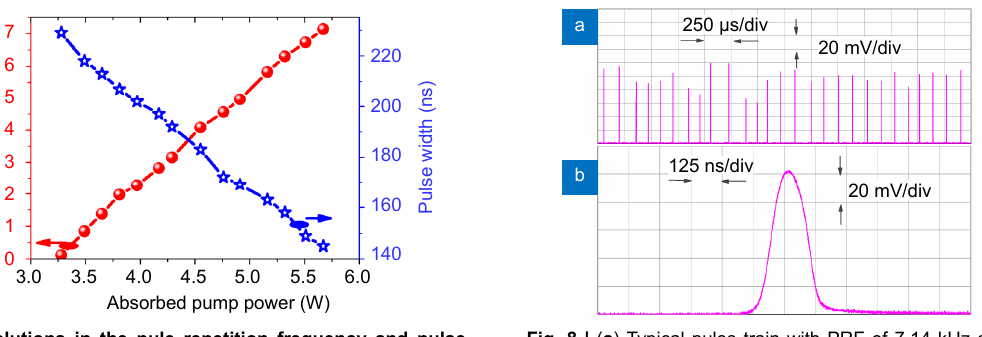
Fig. 7 | Evolutions in the pule repetition frequency and pulse width with the absorbed LD power.